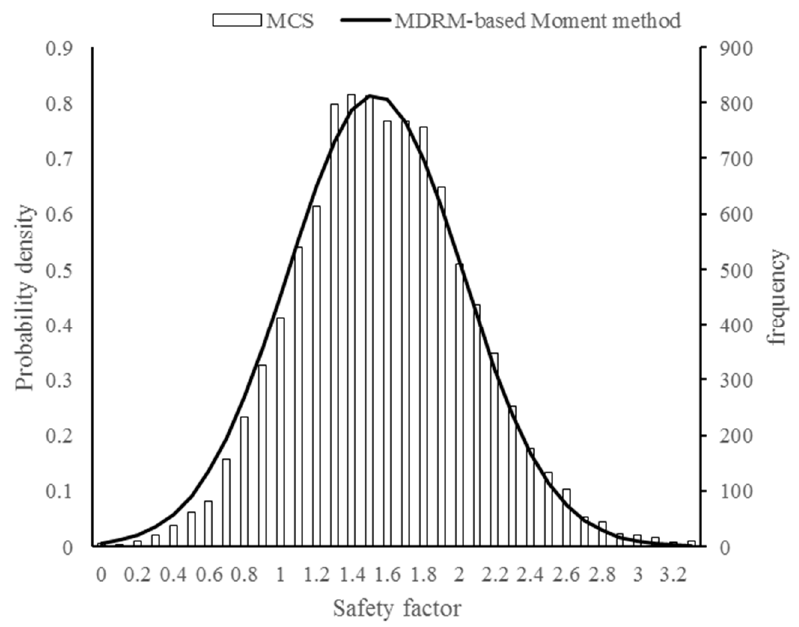
Figure 7. Probability distribution of safety factor and its comparison with MCS for frictional soil with pore pressure.